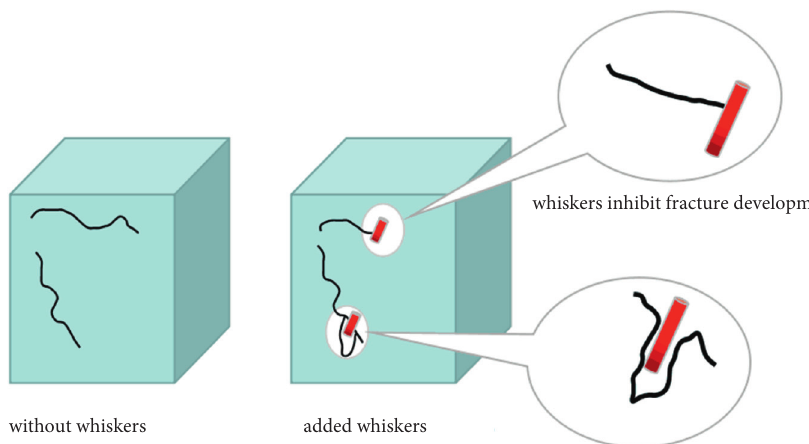
without whiskers Figure 9: Crack propagation mechanism.